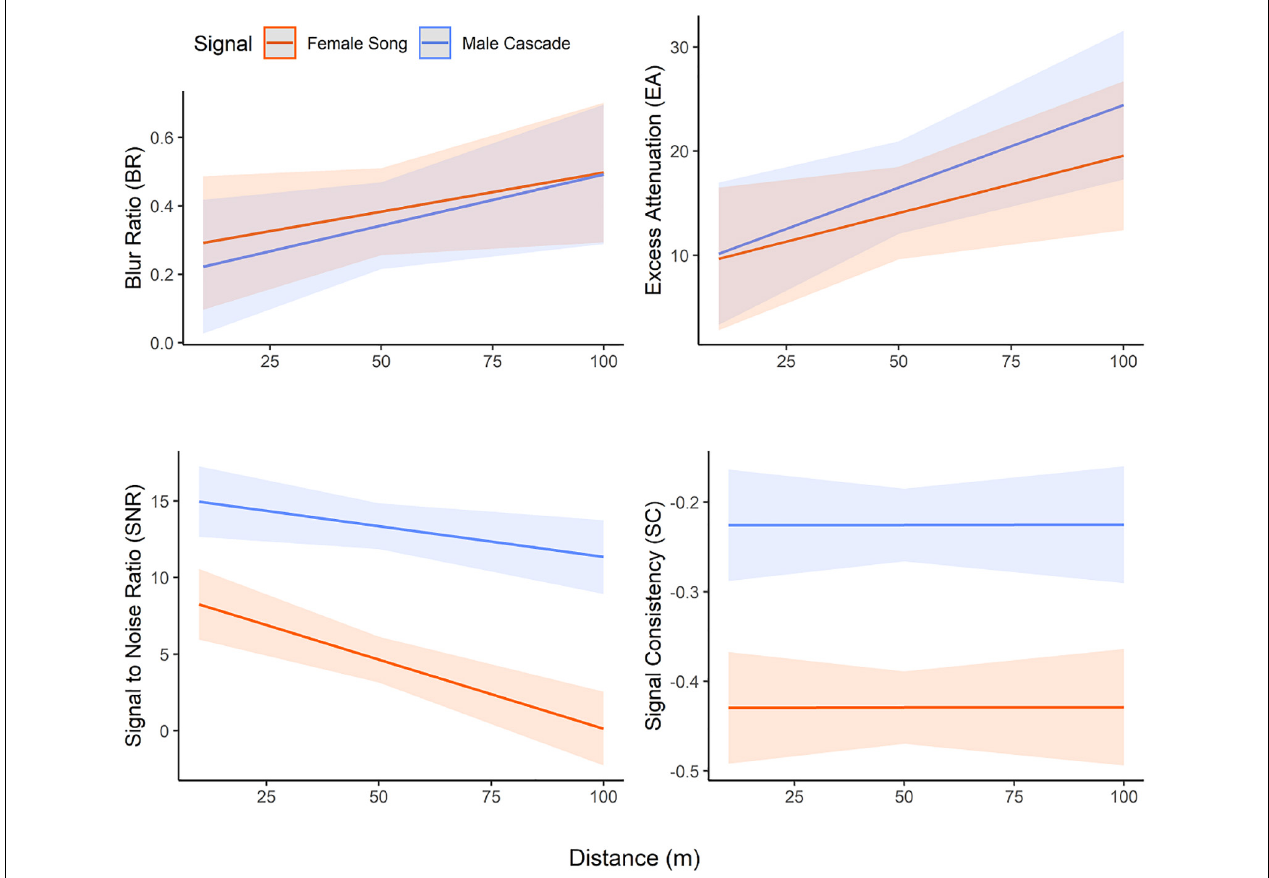
FIGURE 2 | Modeled metrics of propagation quality and consistency for canyon wren female songs and male cascades over distance. Model includes 20 pairs of male and female songs, with sex, distance, and pair identity as fixed